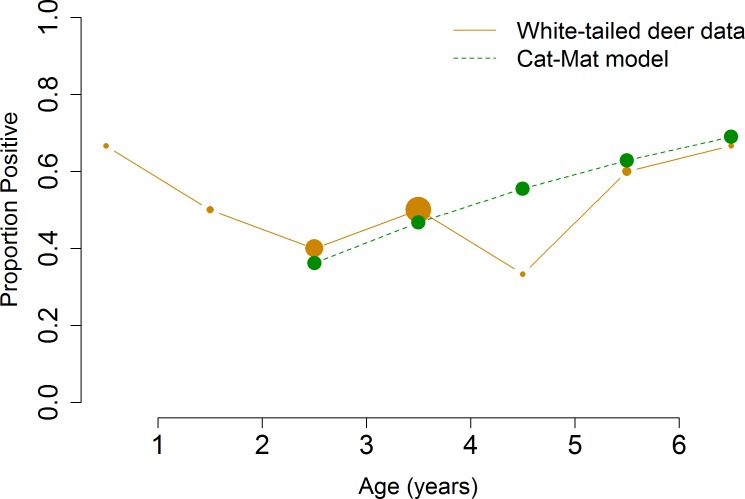
Model selection for white-tailed deer.Catalytic model with maternal antibodies was the best-fit model for white-tailed deer. Size of points represents the relative number of animals sampled with that age.